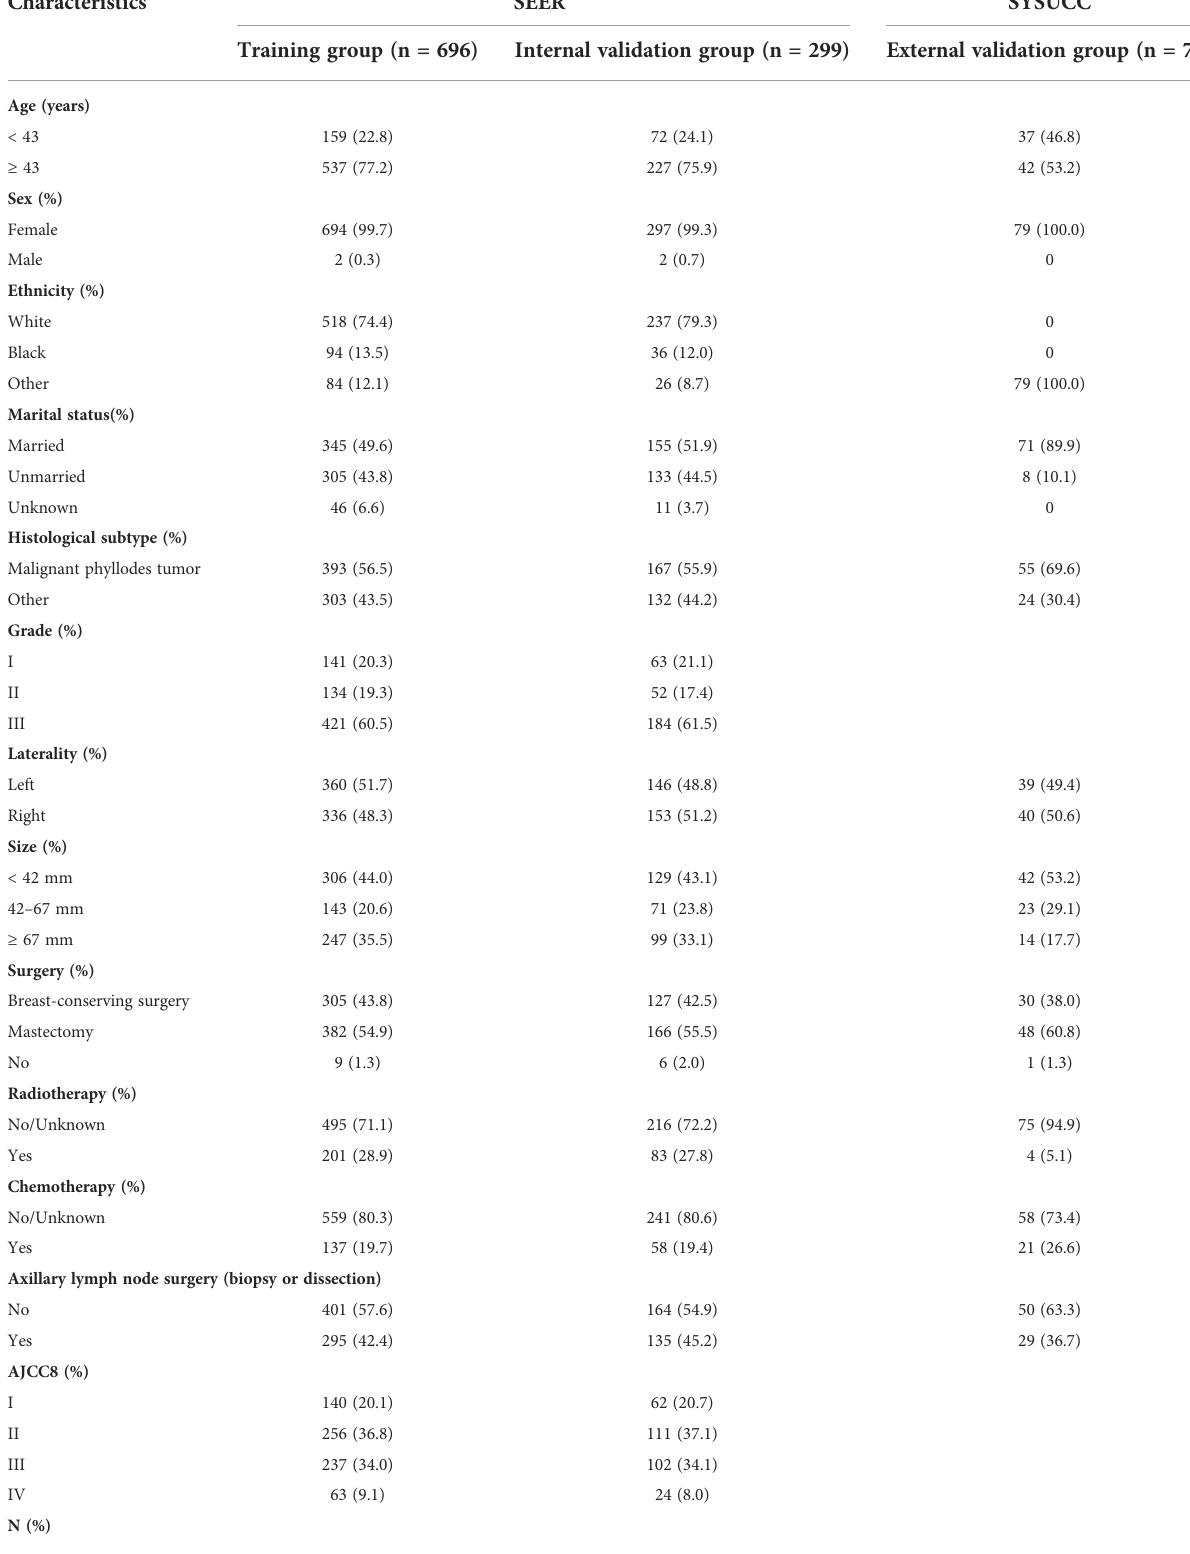
TABLE 1 Baseline demographic and clinical characteristics of the